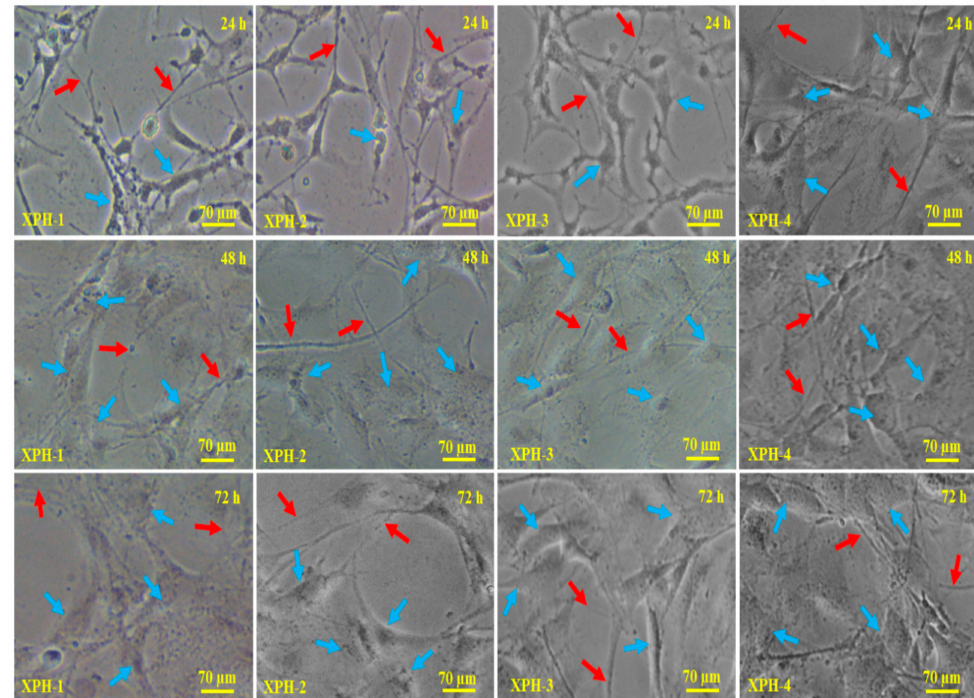
Figure 8. In vitro cell morphology of MC3T3-E1 cells onto the hybrid nanocomposite scaffolds (XPH-1, XPH-2, XPH-3, and XPH-4) at different times (24, 48, and 72 h). The red arrows present the thread-like morphologies of the cells whereas the blue arrows show the mature cylinder-like morphologies of the